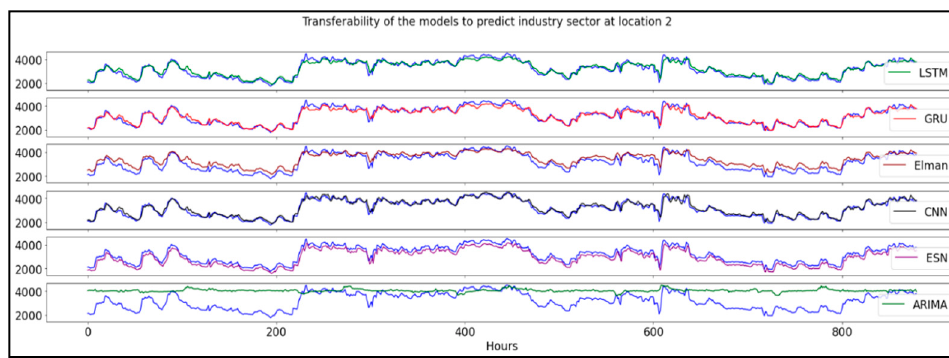
Figure 7. Short-term transferability predictions. The models are trained on the time series at location 1 to predict the energy consumption at location 2.